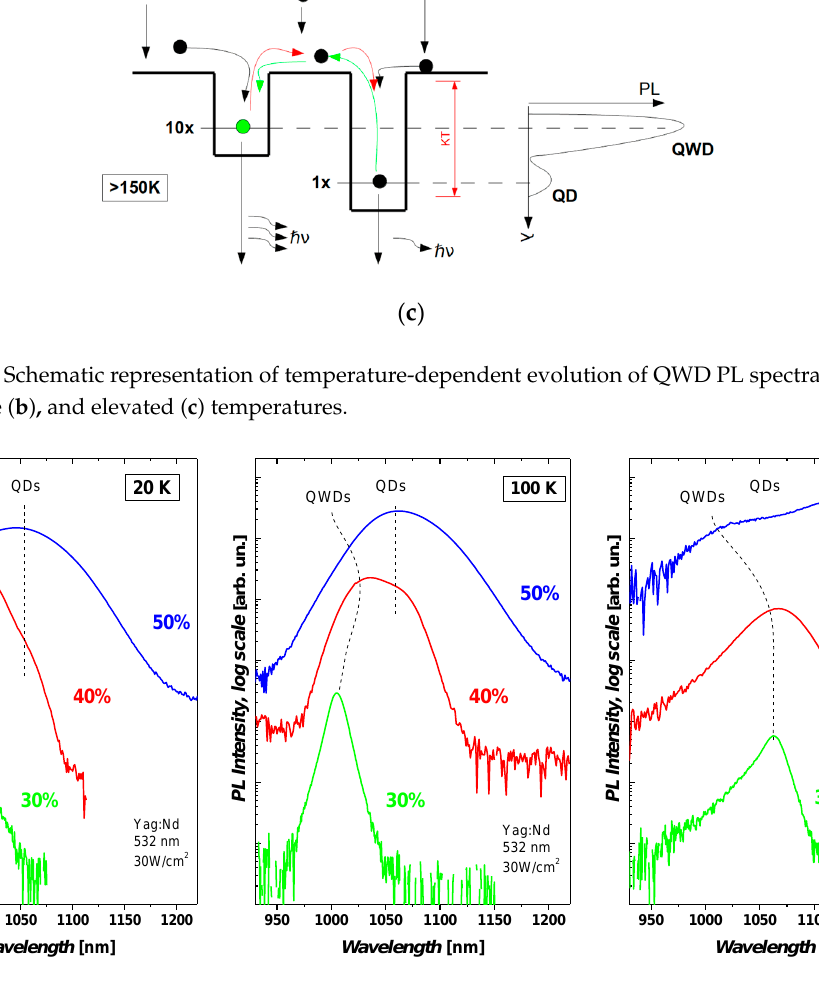
Figure 5. Schematic representation of temperature-dependent evolution of QWD PL spectra: low ( a ), moderate ( b ) , and elevated ( c ) temperatures.